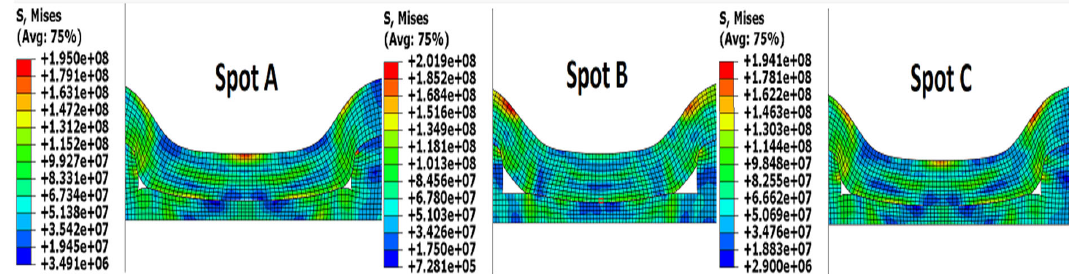
Figure 18. Von Mises stress (MPa) contours after deformation of the three spots.